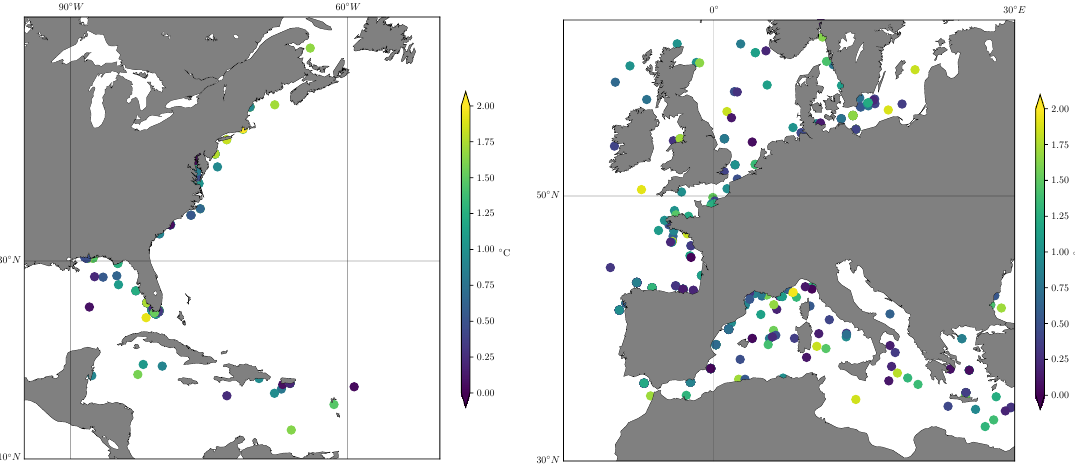
Figure 5. Detail extracted from Figure 4 showing the difference between measured and predicted temperature in test locations for the United States ( left ) and Europe ( right